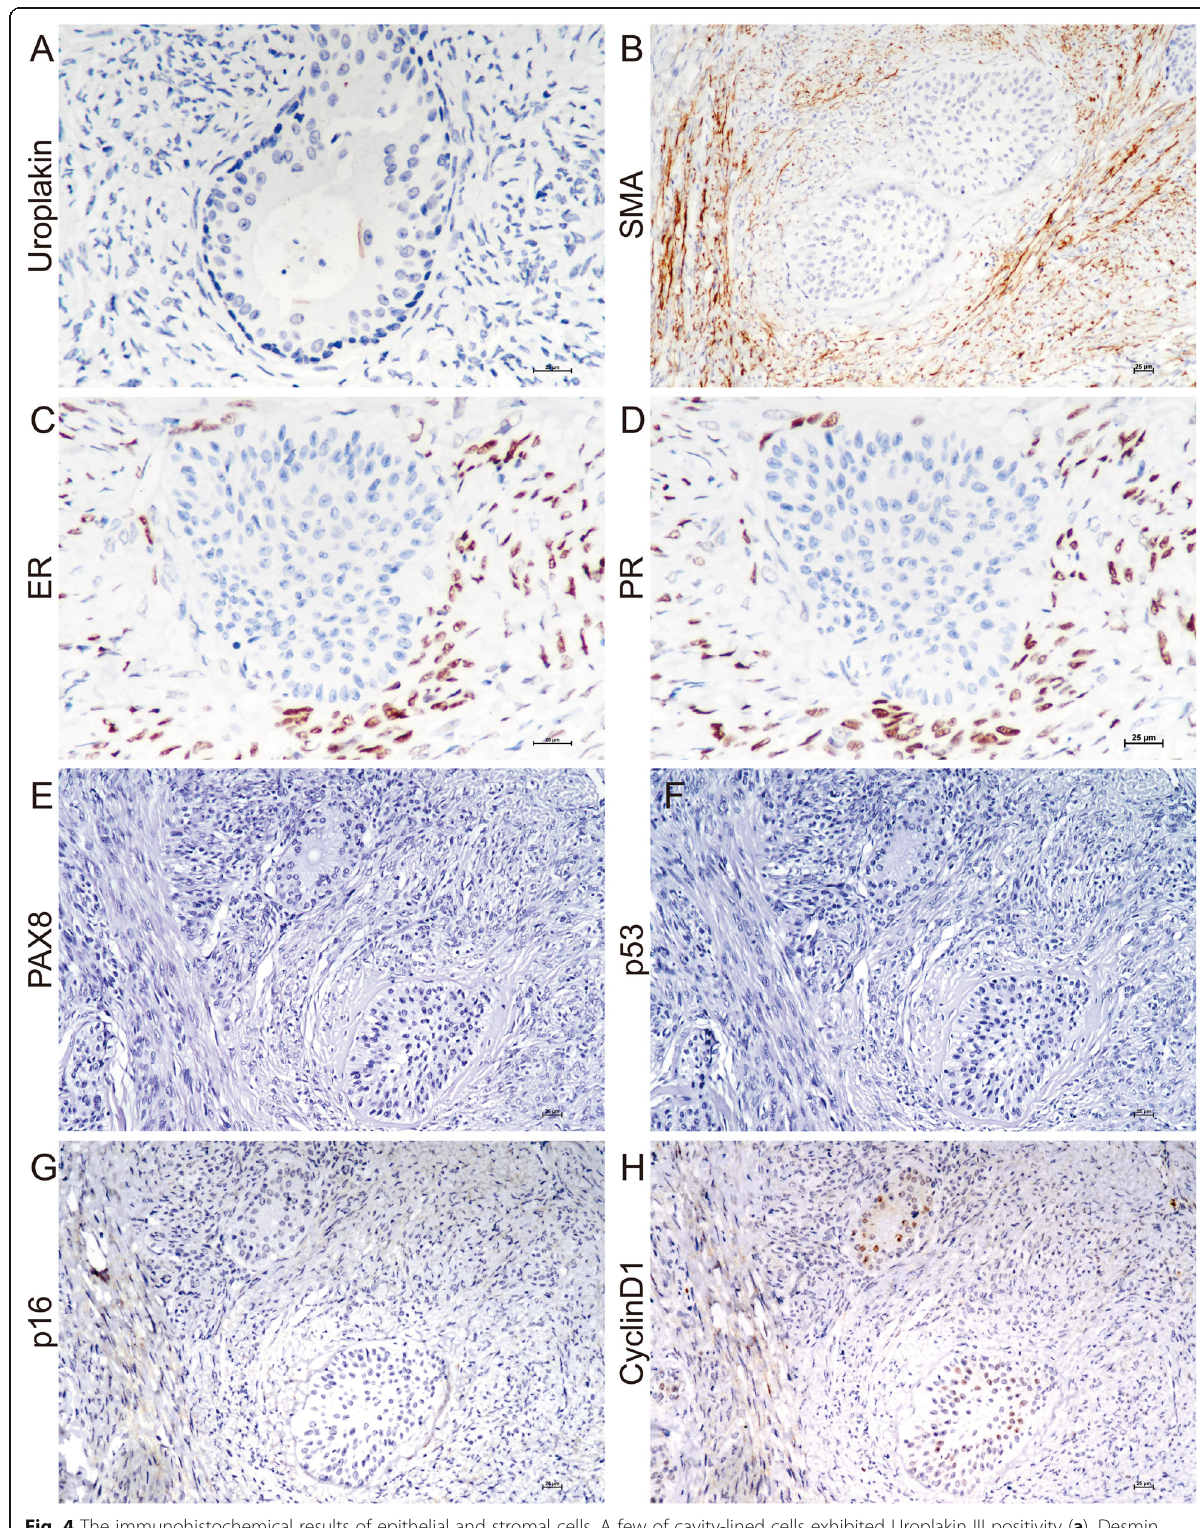
Fig. 4 The immunohistochemical results of epithelial and stromal cells. A few of cavity-lined cells exhibited Uroplakin III positivity ( a ). Desmin immunopositivity confirmed smooth muscle nature of stromal cells ( b ). Stromal cells expressed ER ( c ) and PR ( d ). Tumor cells were negative for PAX8, p53, and p16 ( e - g ). The epithelium showed weak positivity for cyclinD1 ( h ). Original magnification x 200 ( b , e - h ) and x 400 ( a , c , d